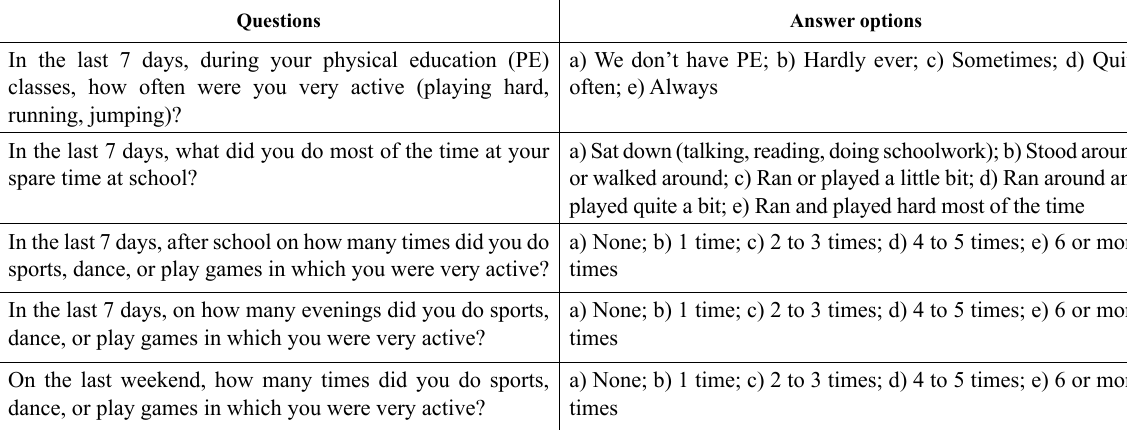
Table 1. Part one: questions on physical activity levels in the past seven